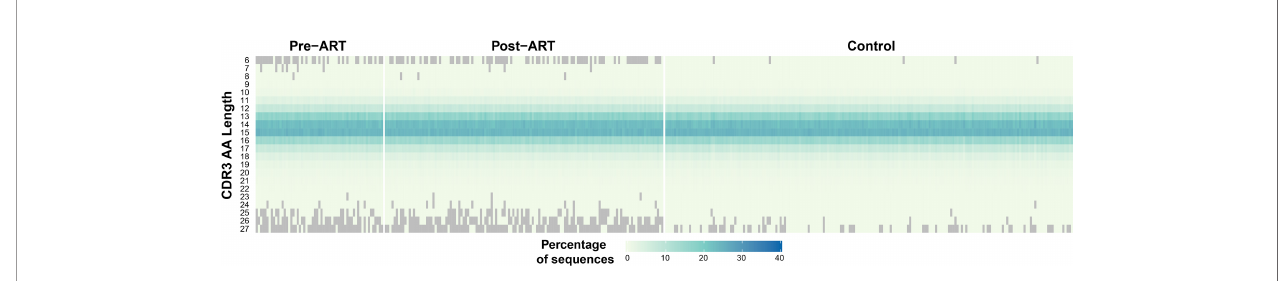
FIGURE 6 | Narrower distribution of CDR3 region lengths encoded in TRB sequences in PLHIV repertoires compared to control repertoires. Heatmap demonstrating the length distribution (plotted along vertical axis) of the CDR3 regions encoded by the TRB sequences in the pre- and post-ART repertoires of the PLHIV cohort (left side of fi gure) and in 189 bone marrow transplant donors (right side of fi gure) each sampled at a single